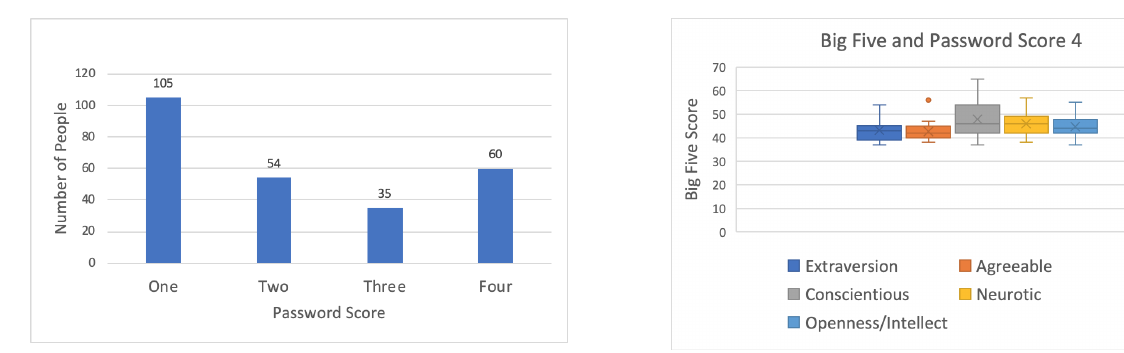
Figure 3. Big Five personality traits and password strength. This graph only includes zxcvbn password score four and Big Five personality trait scores above